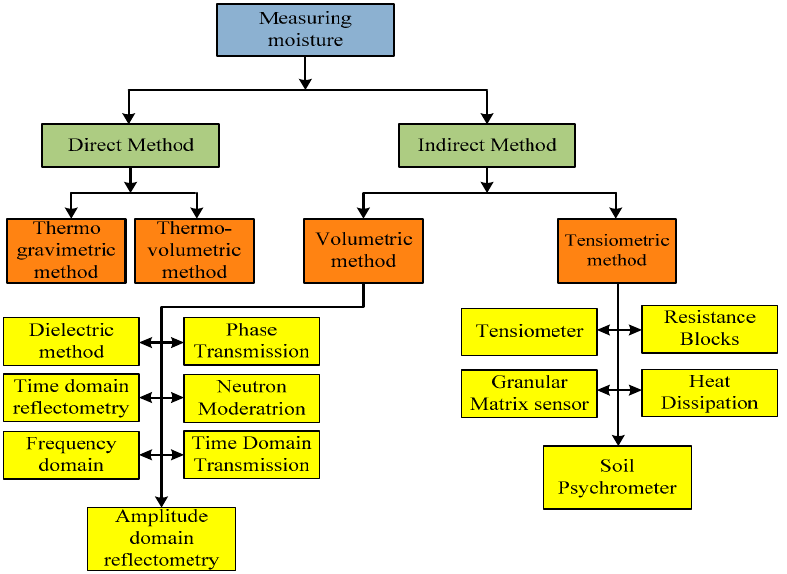
Figure 10. Methods of moisture sensors.